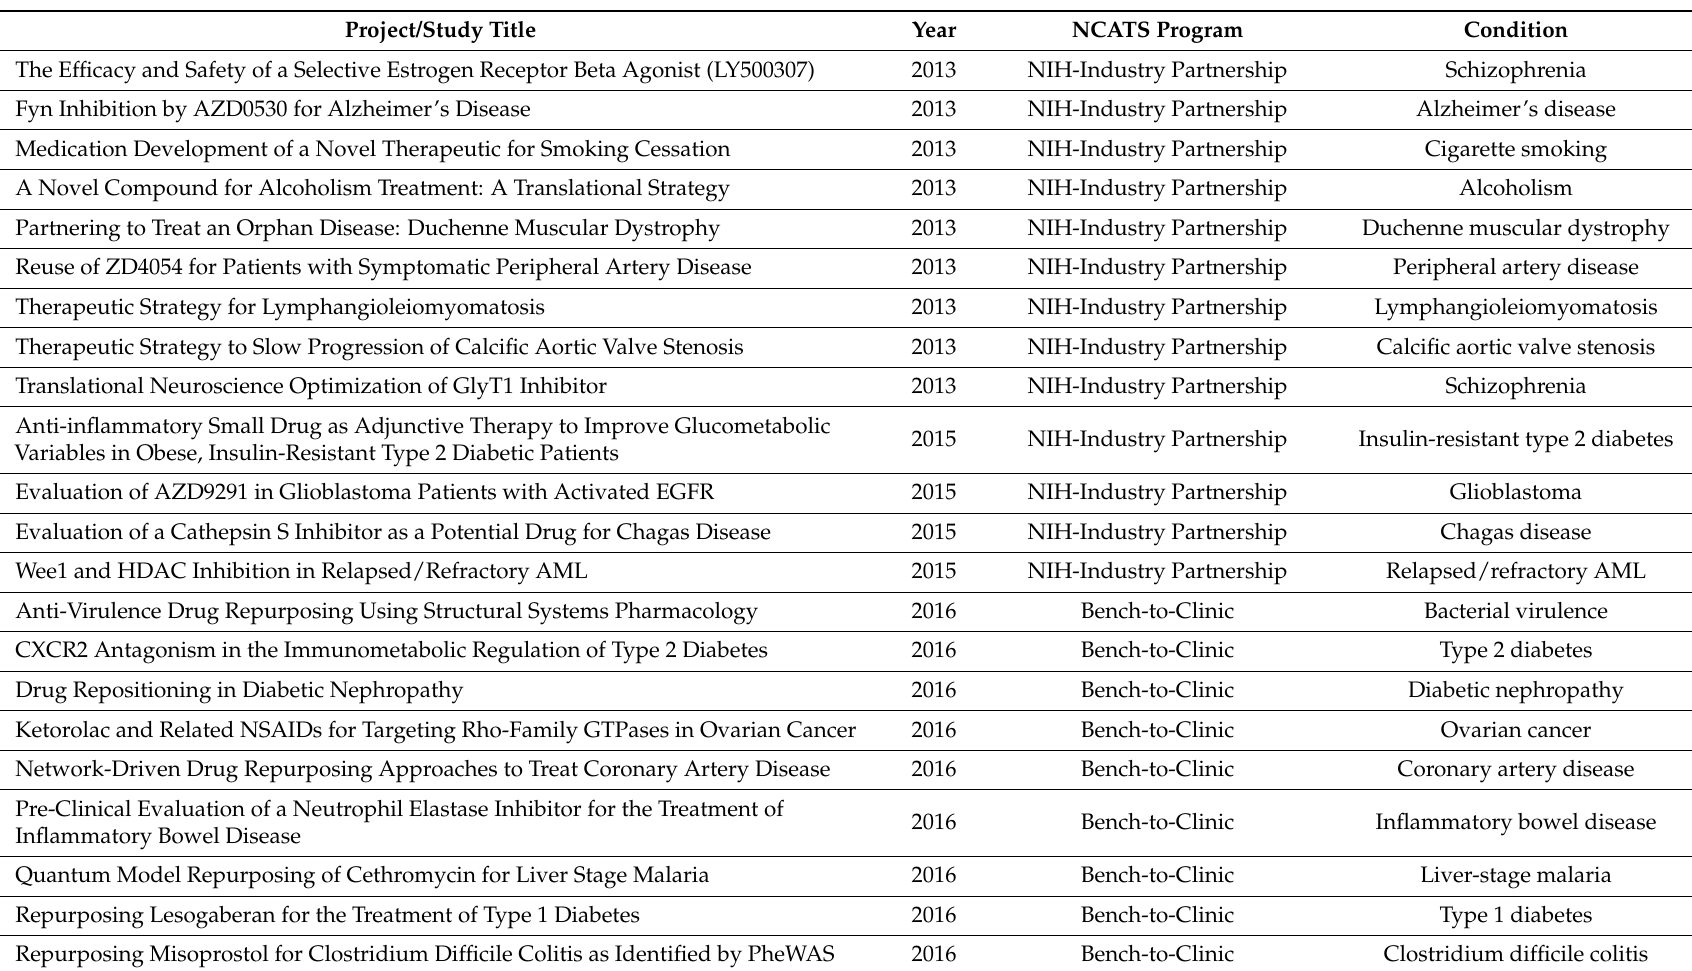
Table 4. NIH-NCATS funded new therapeutic uses projects